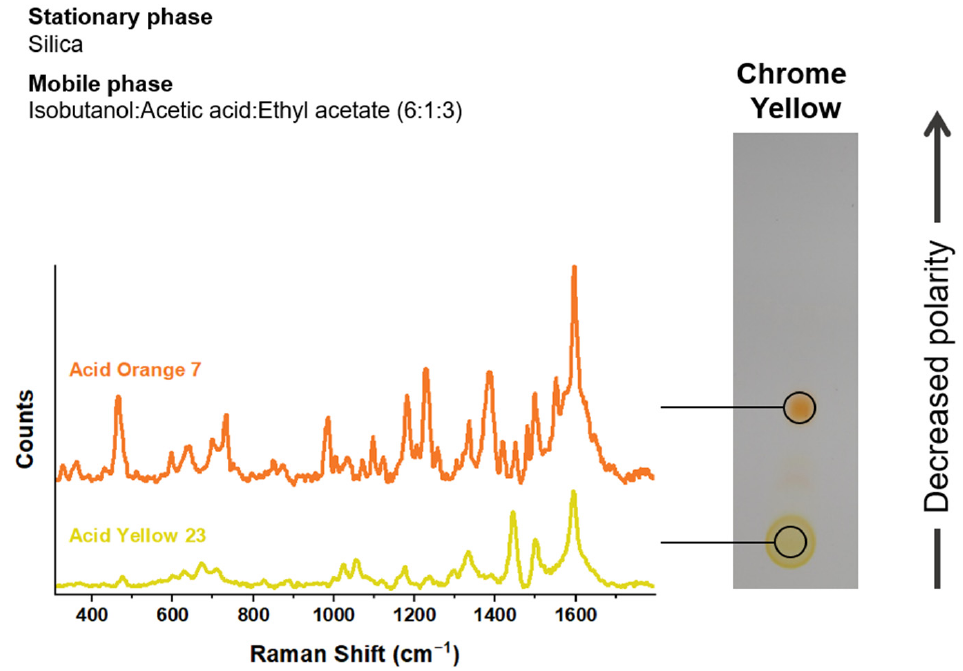
Figure 4 . Example TLC-SERS analysis on Chrome Yellow from the set of Dr. Ph. Martin’s Synchro- matic Transparent Water Colors, which identified Acid Orange 7 and Acid Yellow 23. © 2022 The Museum of Modern Art,